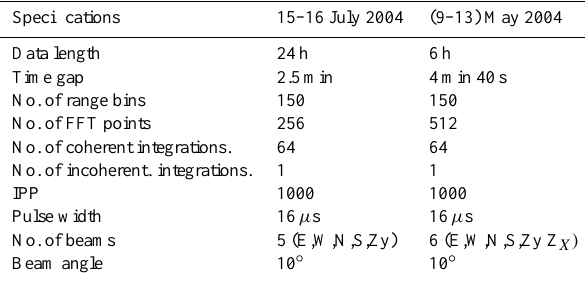
Table 1. Experimental